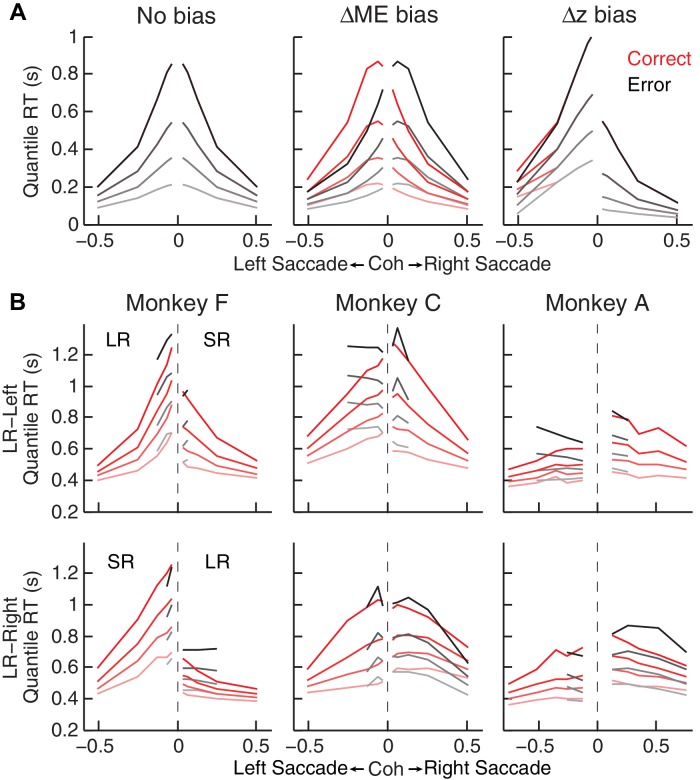
Qualitative comparison between the monkeys’ RT distribution and DDM predictions.(A) RT distributions as predicted by a DDM with no bias in decision rule (z) or momentary evidence (me; left), with me > 0 (middle), and with z > 0.5 (right). RT distributions are shown separately for correct (red) and error (black) trials and using values corresponding to 20th, 40th, 60th, and 80th percentiles. The predictions assumed zero non-decision time to demonstrate effects on RT by only me or z biases. Positive/negative coh values indicate rightward/leftward saccades. The values of me and z were chosen to induce similar choice biases (~0.075 in coherence units). Note that the me bias induces large asymmetries in RT both between the two choices and between correct and error trials, whereas the z bias induces a large asymmetry in RT for the two choices, but with little asymmetry between correct and error trials. (B) The monkeys’ mean RTs for four quantiles for the LR-Right (top) and LR-Left (bottom) reward contexts, respectively (same convention as in A). Note the presence of substantial asymmetries between correct and error trials for all three monkeys.